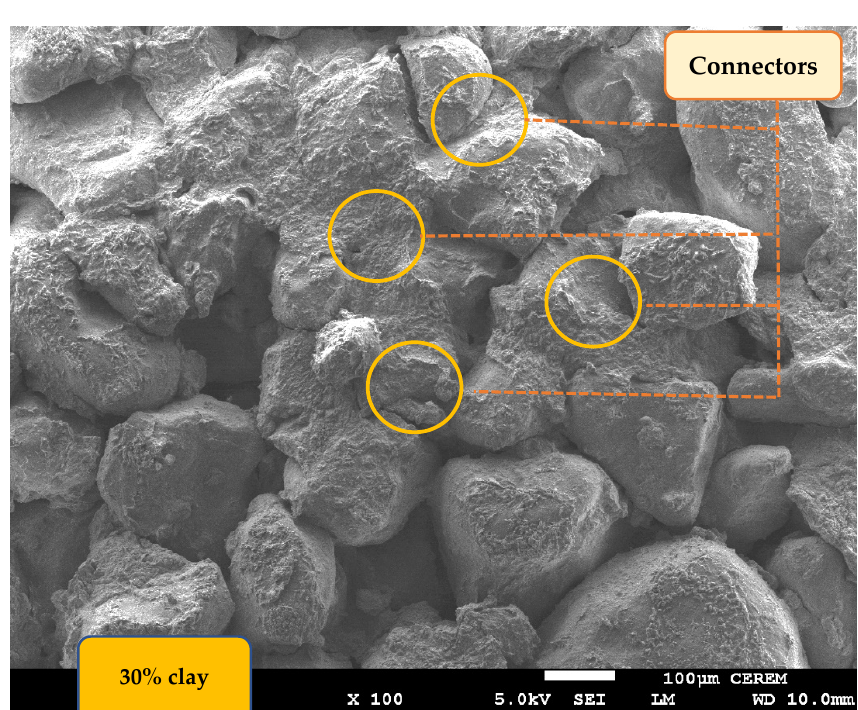
Figure 13. SEM of sand clay mixture with 30% clay content.